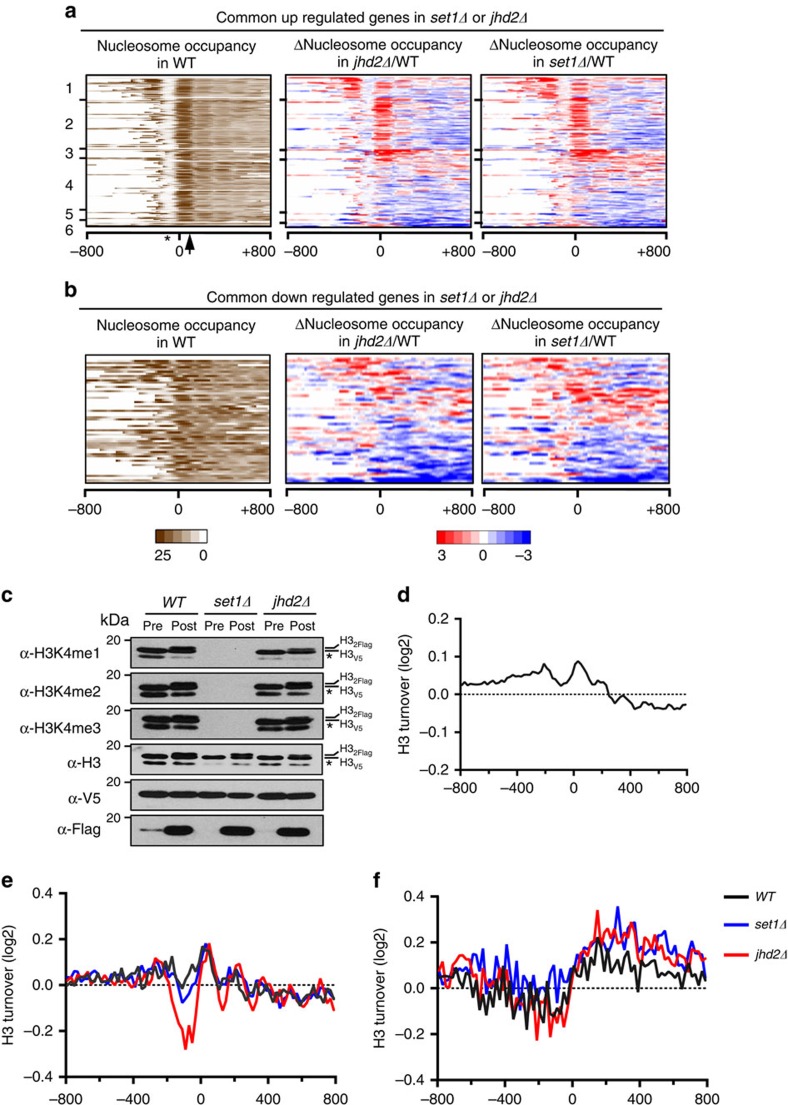
Set1 and Jhd2 co-regulate nucleosomal occupancy and histone turnover at their shared target genes.(a,b) Heat maps for nucleosome occupancy ratios (Δnucleosome occupancy) between jhd2Δ and WT or between set1Δ and WT at genes either co-repressed (a) or co-activated (b) by Set1 and Jhd2. Red, gain in nucleosome occupancy; blue, loss in nucleosome occupancy. Genes in rows are organized into six groups using k-means clustering. Columns represent 50 bp windows over ±800 bp regions relative to the TSS (0). Windows overlapping neighbouring genes were excluded. Total reads for mononucleosomal DNA in WT show the native state of nucleosome occupancy (leftmost panel). Asterisk, NDR; black arrow, the well-positioned +1 nucleosome. (c) Western blots showing RITE. WT, set1Δ and jhd2Δ strains expressing histone H3 tagged with V5-LoxP-HygMX-LoxP-2Flag cassette were grown overnight in YPD medium and then grown to saturation followed by addition of β-estradiol to induce tag switch. Saturated cultures were re-inoculated into fresh medium to release cells into the cell cycle in the presence of β-estradiol. Cells were arrested in G1 using α-factor. Cells before addition of β-estradiol (pre) and β-estradiol-treated G1 cells (post) were collected for whole-cell lysate preparation and detection of old (V5) and new (Flag) histone H3. The levels of H3K4me1, H3K4me2, H3K4me3 and total histone H3 in the indicated strains are shown. 2Flag, two copies of Flag tag; asterisk, truncated H3. See Supplementary Fig. 22 for full-length image of blots. (d) The average mean profile for histone H3 turnover across 800 bp region upstream (−) or downstream (+) of the TSSs (0) at all yeast genes. (e,f) Mean profiles for histone H3 turnover across regions (as described for d) at genes co-repressed (e) or co-activated (f) by Set1 and Jhd2 in WT, set1Δ and jhd2Δ strains.